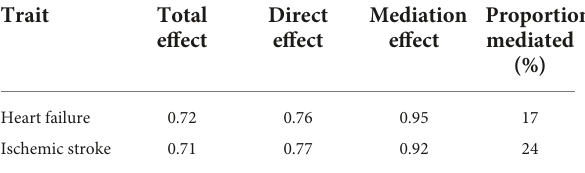
TABLE 4 Mediated Mendelian randomization